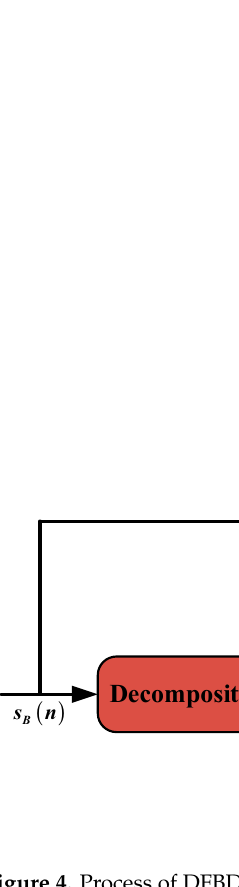
Figure 3. Type of FMCW modulation. The blue and red line represent the emitted signal 𝑠 (cid:3021) (𝑡) and echo signal 𝑠 (cid:3019) (𝑡) , respectively.